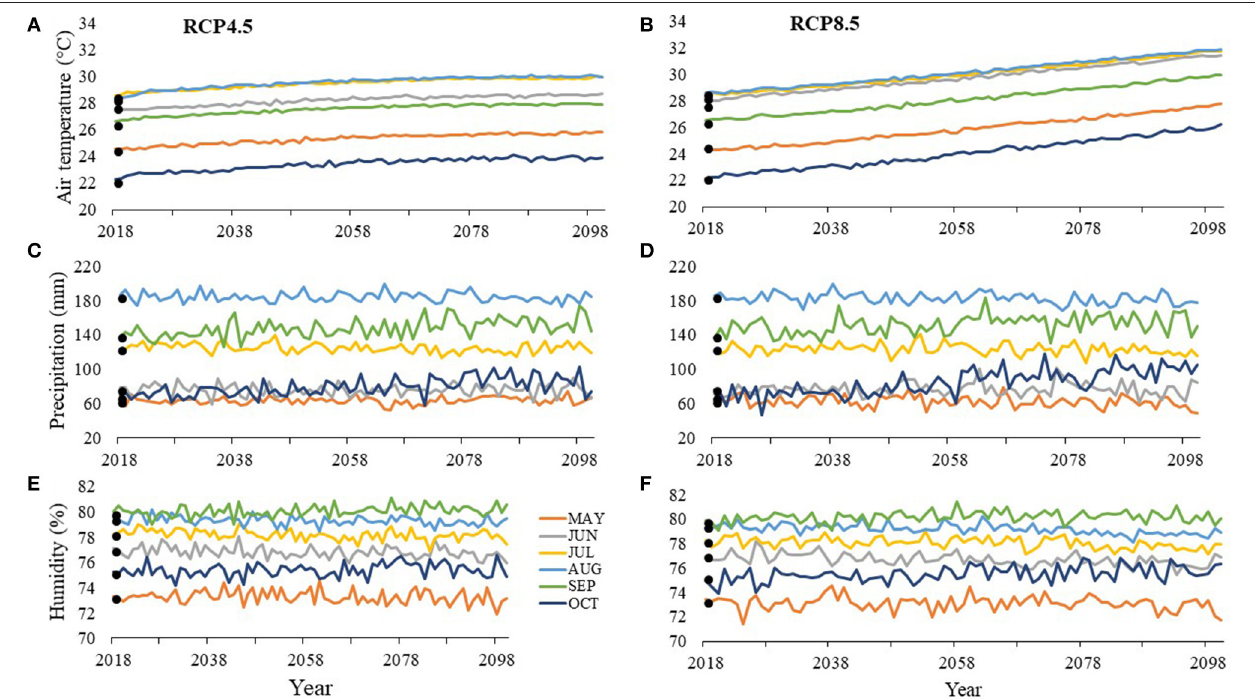
FIGURE 5 | Average values between 2013 and 2016 (solid points) and projected values (lines) for (A, B) air temperature, (C, D) precipitation, and (E, F) humidity at T.H. Stone Memorial St. Joseph Peninsula (SJP) for months within the nesting and hatching season (May–October). RCP4.5 projections, where greenhouse gas concentrations stabilize, are on the left (A, C, E) , while RCP8.5 projections, where greenhouse gas concentrations continuously increase, are on the right (B, D, F) .